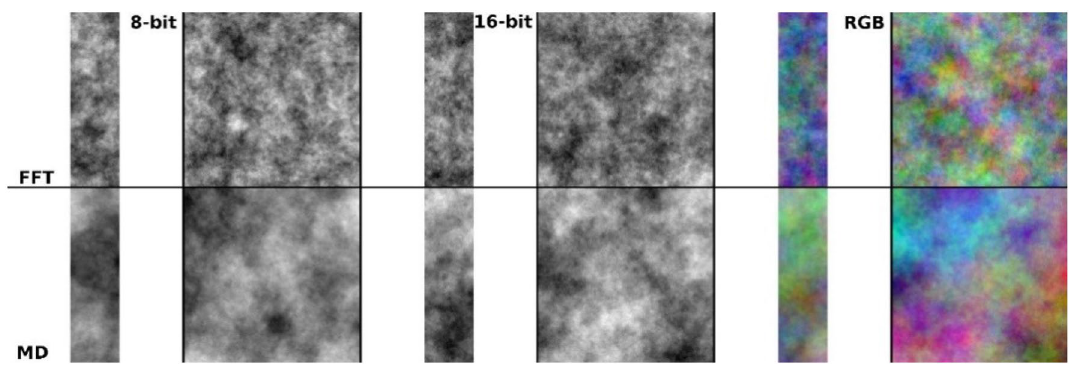
Figure 13. 8-bit, 16-bit and RGB FS images with fractal dimension of 2.5. Upper panel: Inverse FFT algorithm. Lower panel: MD algorithm. Resolutions: 281 × 1000 pixels and 1000 × 1000